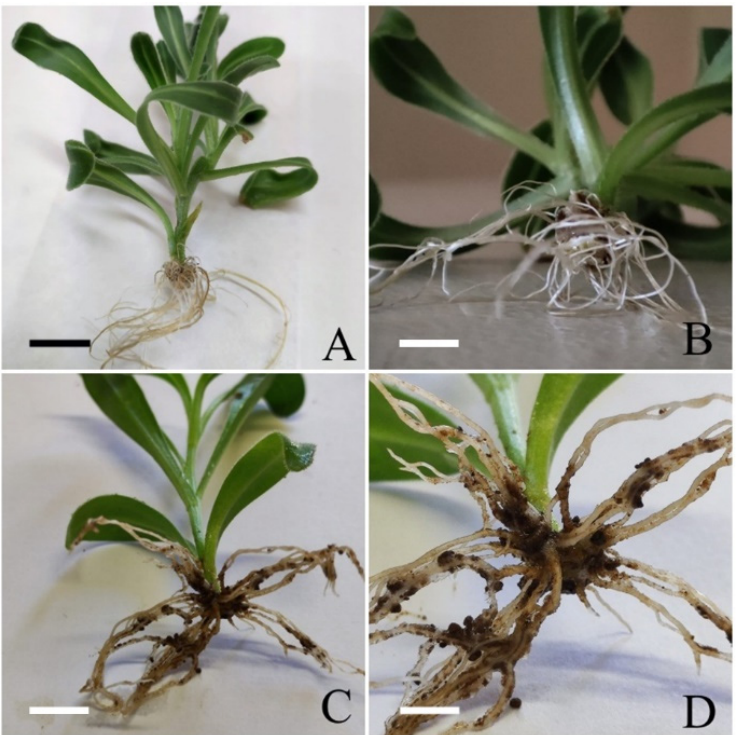
Figure 2. Root formation under different culture conditions after 30 days of culture. ( A ) Rooted plant obtained on MS medium supplemented with 5 µ M IAA (bar: 2 cm). ( B ) Particulars of root apparatus obtained on MS medium (bar: 0.5 cm) ( C ) Rooted plant obtained on Zeolite supplemented with 5 µ M IAA (bar: 2 cm). ( D ) Particular of root apparatus obtained on Zeolite + 5 µ M IAA (bar: 0.5 cm). All pictures were taken after 30 days of culture.